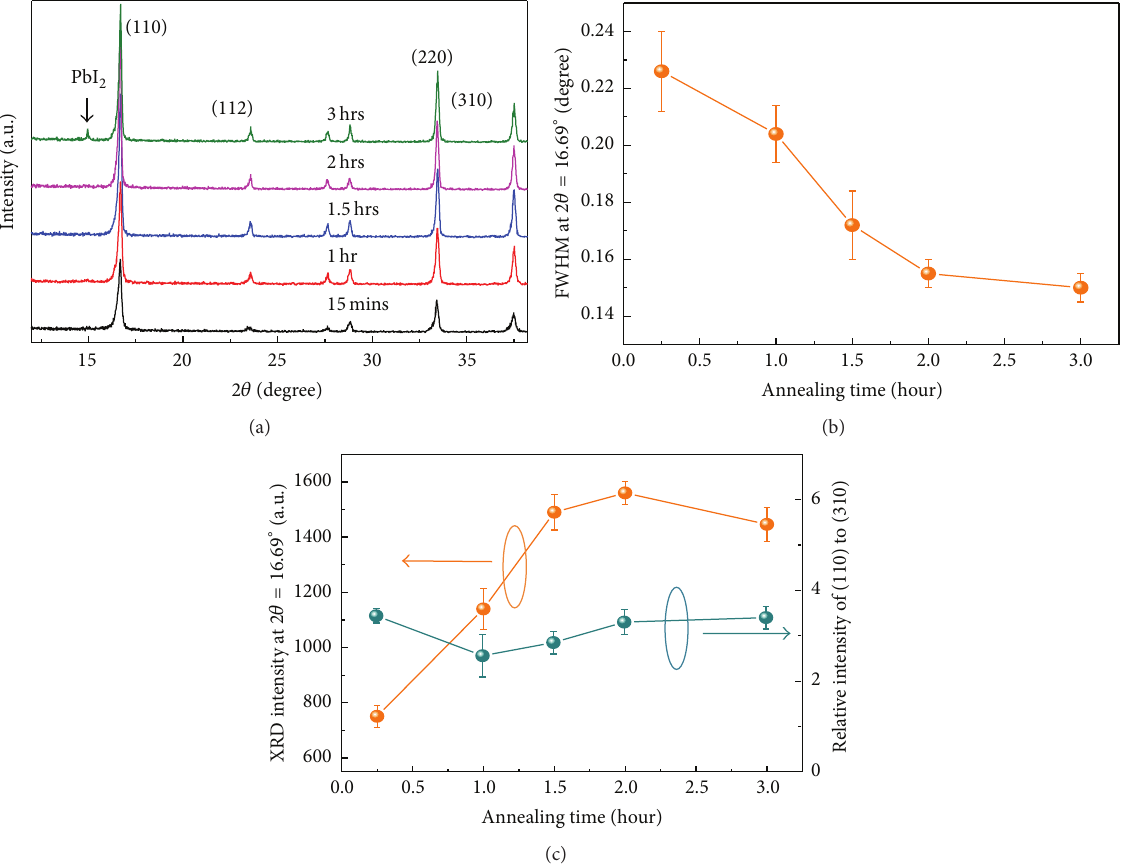
Figure 3: As the annealing time changes, there is an evident evolution of (a) X-ray diffraction (XRD) peaks, (b) FWHM of the (110) diffraction peak, and (c) XRD intensities. Reproduced from [21] with permission from the Royal Society of